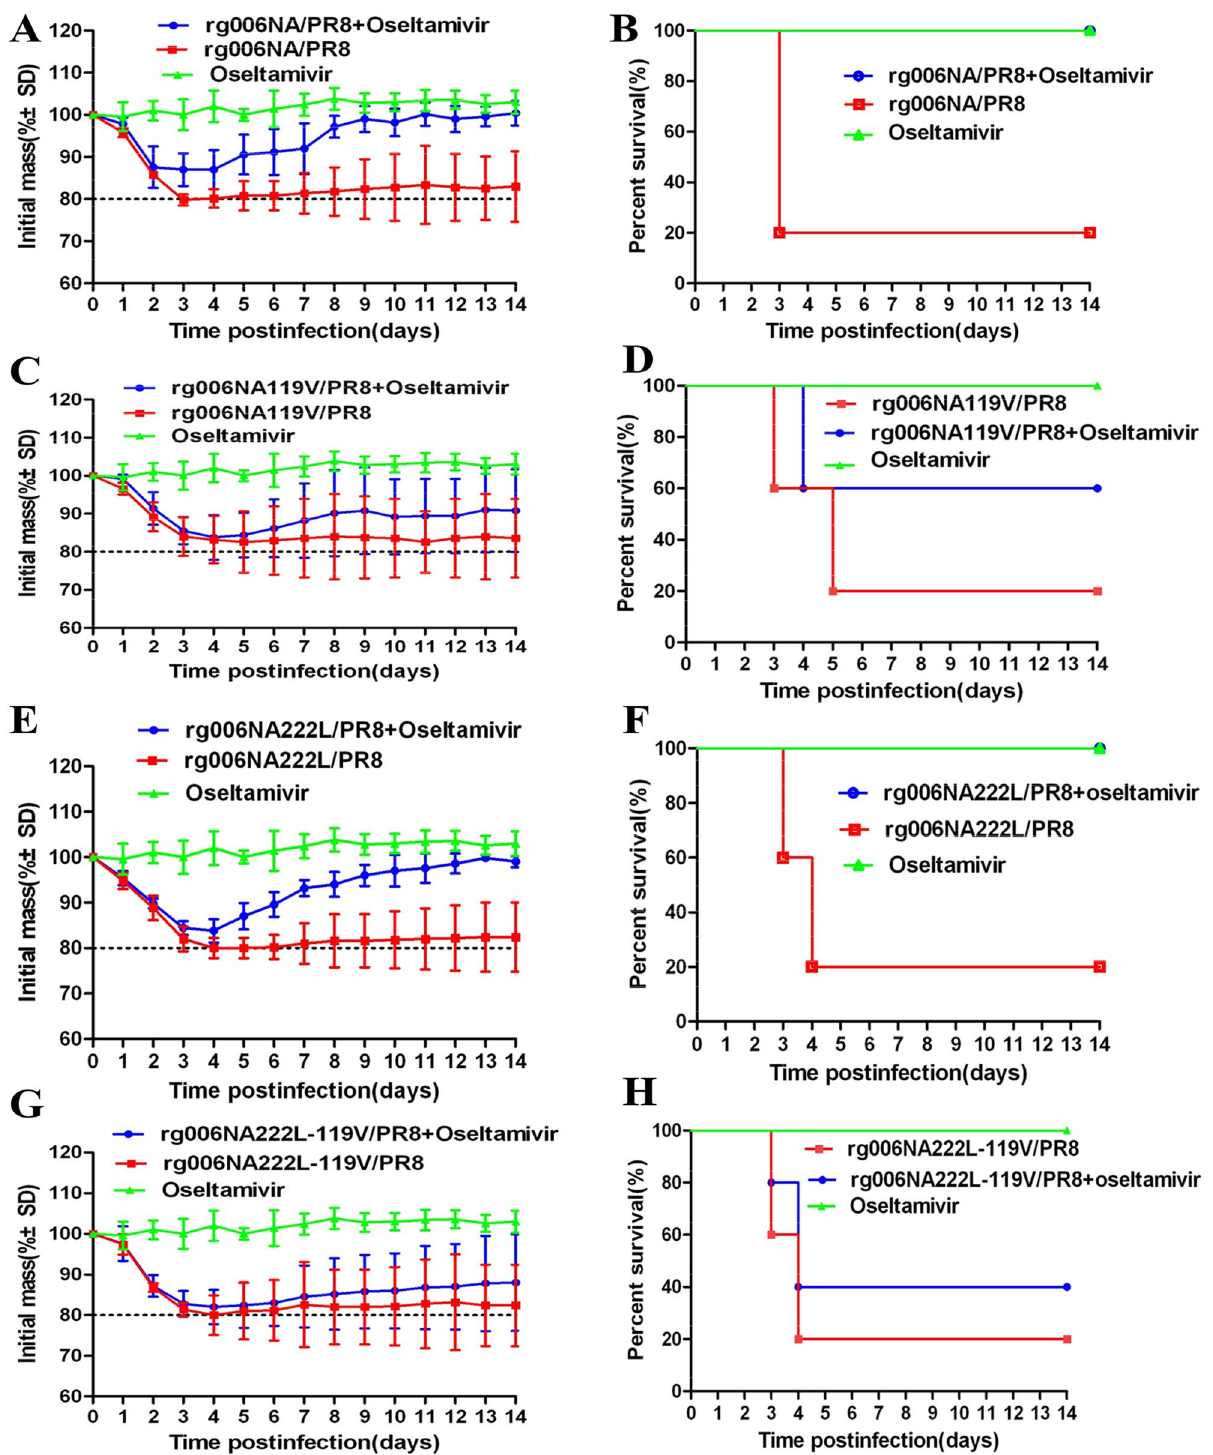
Figure 5. Body weight curve and survival condition of mice infected with H7N9/PR8 recombinant viruses treated with oseltamivir phosphate. The C57 mice were infected with 2MLD 50 rg006NA/PR8, rg006NA119V/ PR8, rg006NA222L-119V/PR8 and rg006NA222L/PR8 (n = 5/group). The mice in the drug treatment group were given 20 mg/kg/day oseltamivir phosphate by gavage from 0 to 4 dpi, and the mice in the non-drug group were given PBS by gavage from 0 to 4 dpi. On the day of infection, the mice in the control group were given PBS, and then the mice were given 20 mg/kg/day oseltamivir phosphate by gavage. ( A,C,E,G ) weight curve of mice; ( B,D,F,H ) survival condition of mice. ( A,B ) rg006NA/PR8; ( C,D ) rg006NA119V/PR8; ( E,F ) rg006NA222L/ PR8; ( G,H )